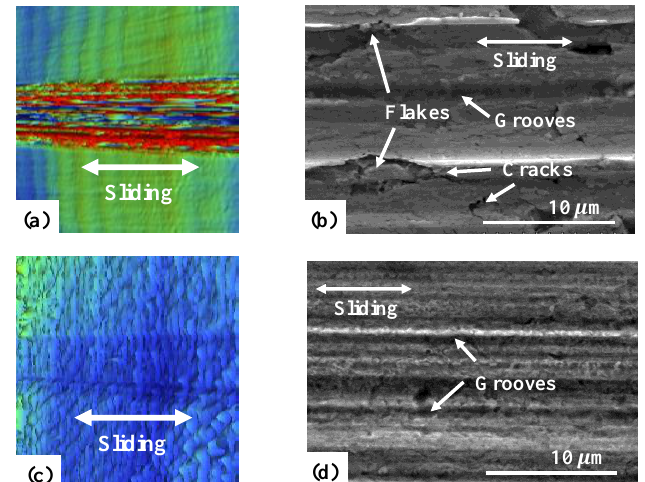
Figure 9. The morphologies of the worn surfaces: ( a ) 3D topography and ( b ) SEM image of crystalline Pd with sliding speed of 3 mm/s and ( c ) 3D topography and ( d ) SEM image of amorphous Pd alloy with sliding speed of 3 mm/s under the IL lubrication at 100 °C.